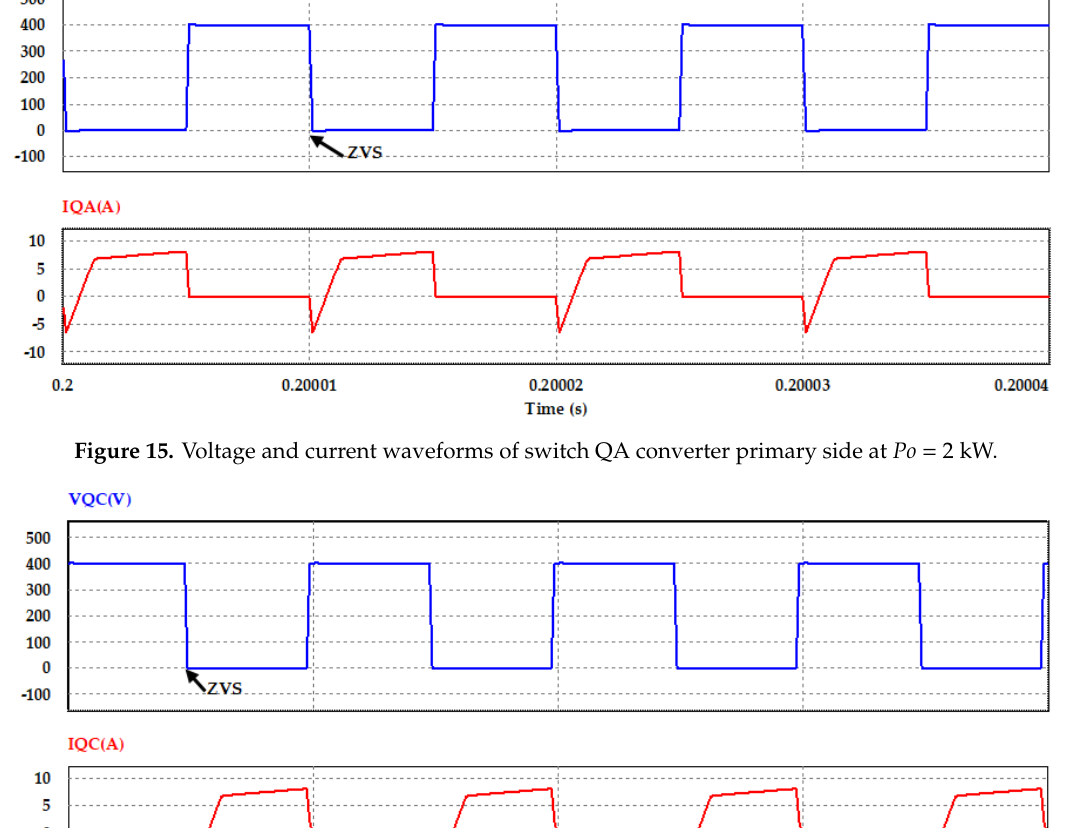
Figure 14. Gate charge waveform of the MOSFET in inrush current mitigation circuit. Phase shift PWM controlling circuit and the resonant inductor are designed to offer ZVS at the voltage waveforms of the switches (QA and QC) in Figures 15 and 16.